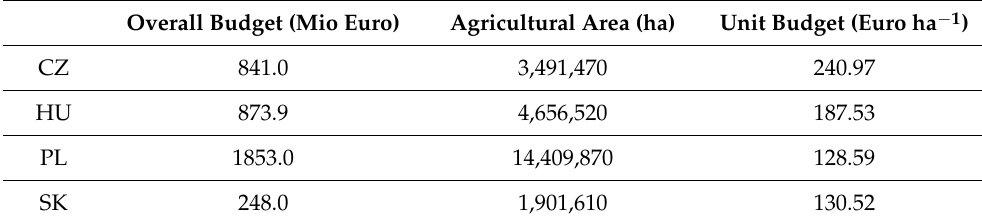
Table 4. Member state allocation to agri-environment measures, 2007–2013 (Mio Euro).